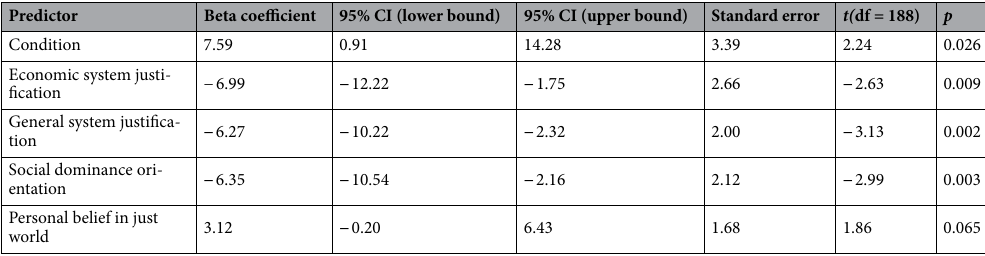
Table 3. Regression results (Study